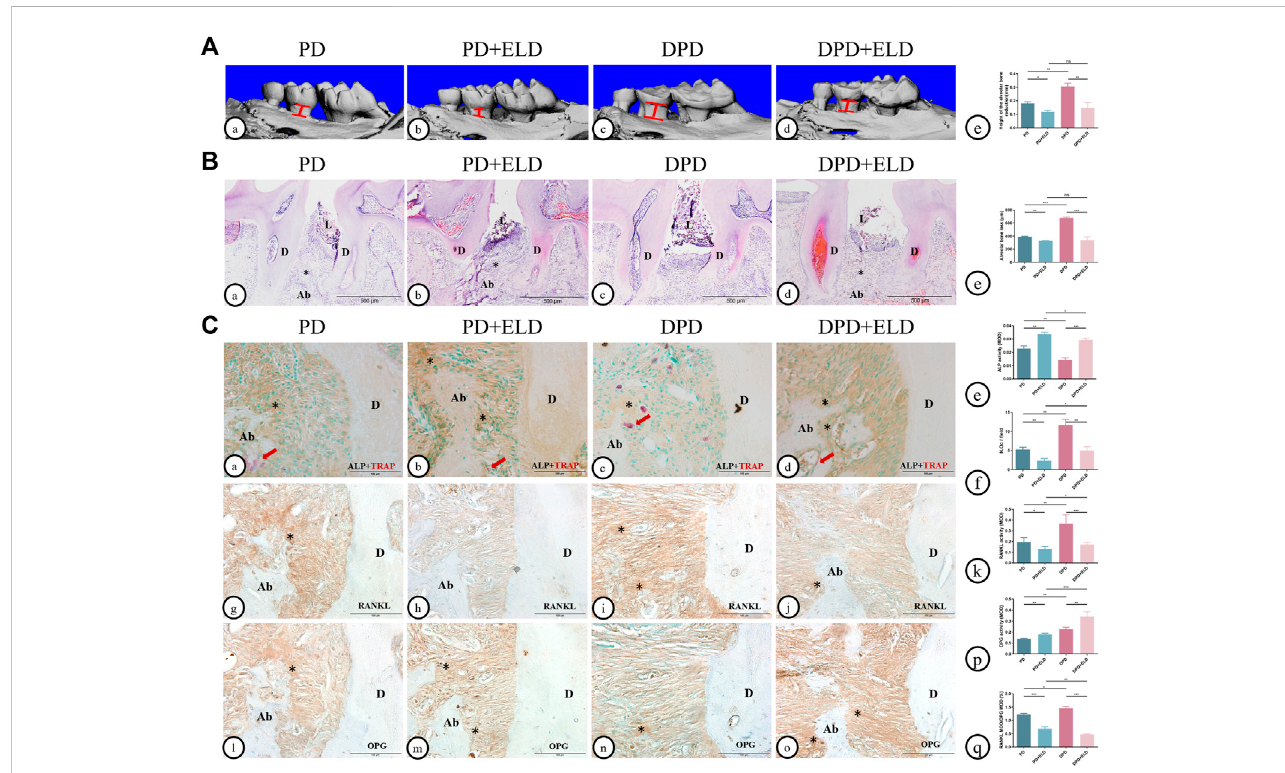
FIGURE 4 Micro-CTanalysisandhistologicalalterationsinthemaxillaryalveolarbonewithELDtreatment. (A) 3Dimagesofmicro-CTinthe(a)PD, (B) PD+ELD,(c) DPD and (d)DPD + ELD groups. (e) Statistical analysis of the data from micro-CT for alveolar bone loss. (B) Low magni fi cation of histological images of the alveolar bone in the (a) PD, (B) PD + ELD, (c) DPD and (d) DPD + ELD groups. (e) Statistical analysis of the data from HE staining for alveolar bone loss. “ * “ , the alveolarridgecrest. (C) DoublestainingforALP(brown)andTRAP(red)inthealveolarboneofthe(a)PD,(b)PD+ELD,(c)DPDand(d)DPD+ELDgroups. Statistical analysis of (e) ALP positive and (f) TRAP positive osteoclast counts. Immunostaining of RANKL in the (G) PD, (h) PD + ELD, (i) DPD and (j) DPD + ELD groups. (k) Statistical analysis of the activity of RANKL. Immunostaining of OPG in the (l) PD, (m) PD + ELD, (n) DPD and (o) DPD + ELD groups. ( p ) Statistical analysis oftheactivityofOPG.(q)TheratioofRANKL/OPG.Positivestaininghasbeen markedwitharrowsor “ * ” inthe fi gures.Datawereshown asmean±SD (* p < 0.05. ** p < 0.01. *** p < 0.001). Ab, alveolar bone; D, dentin; L,